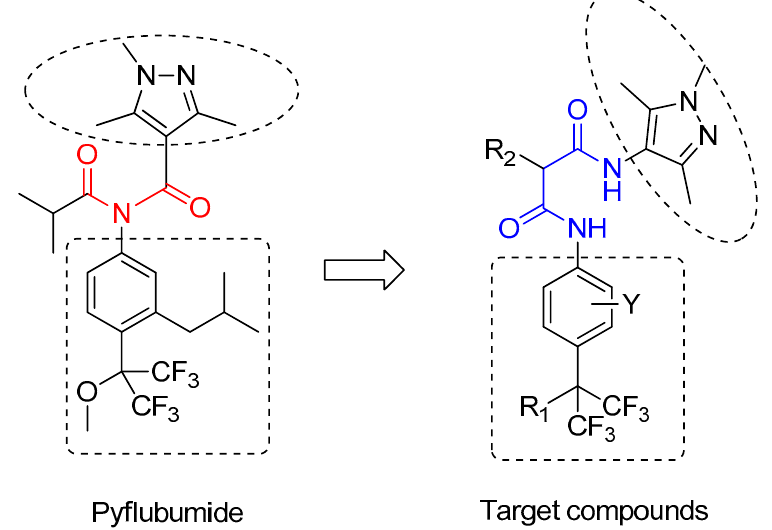
Figure 2. The design of the target compounds.